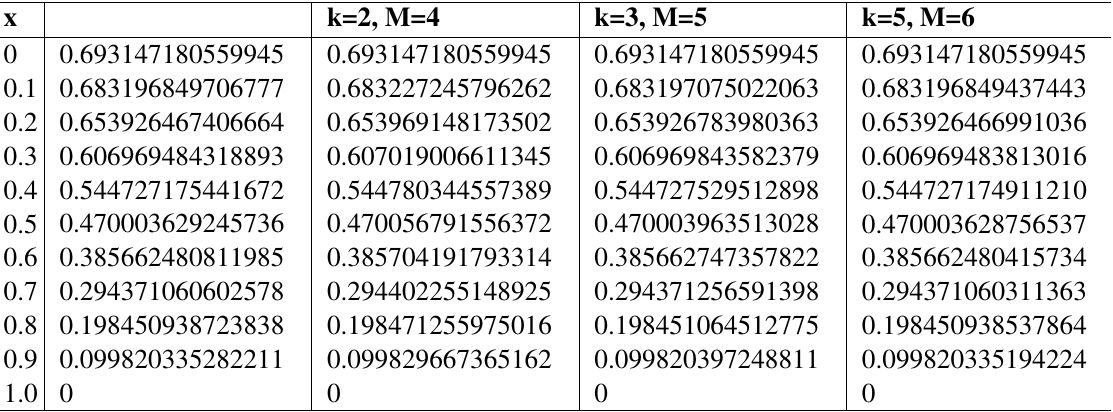
Table 3 Comparison of numerical solutions and exact solutions with different